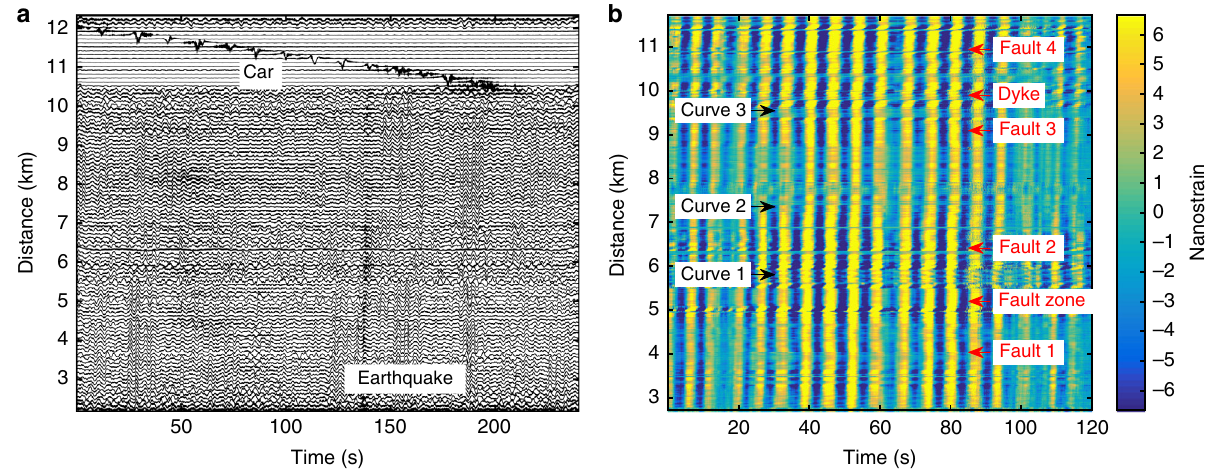
Fig. 2 DAS records. a 4 min of strain signal (17 March 2015, 12:33 – 12:37). Only selected normalized traces (one trace out of 25, i.e. one trace every 100 m, frequency range 0.01 – 100 Hz) are shown. A local earthquake is revealed by higher frequencies in the signal from 135 to 140 s. Coherent oscillations of 5 – 6 s period correspond to ocean-driven micro-seism. Traces between 10.5 and 11.6 km with large amplitude signals correspond to a car travelling on the road along the cable (Methods: Shallow sub-surface crustal properties determination). b 2 min of strain record (19.03.2015, 15:27 UTC) showing micro- seism (4 – 6 s period) propagating from the south coast northwards along the cable. Beamforming computation (from the DAS record) indicates a source in the Atlantic Ocean, SW of Iceland. Changes in cable direction along the road (black labels) induce a change in the incidence angle of the micro-seism waves, and therefore amplitude change. Amplitudes and phases are disturbed at speci fi c locations (indicated by the red labels), which correspond to geological features such as faults or volcanic dykes (Fig.